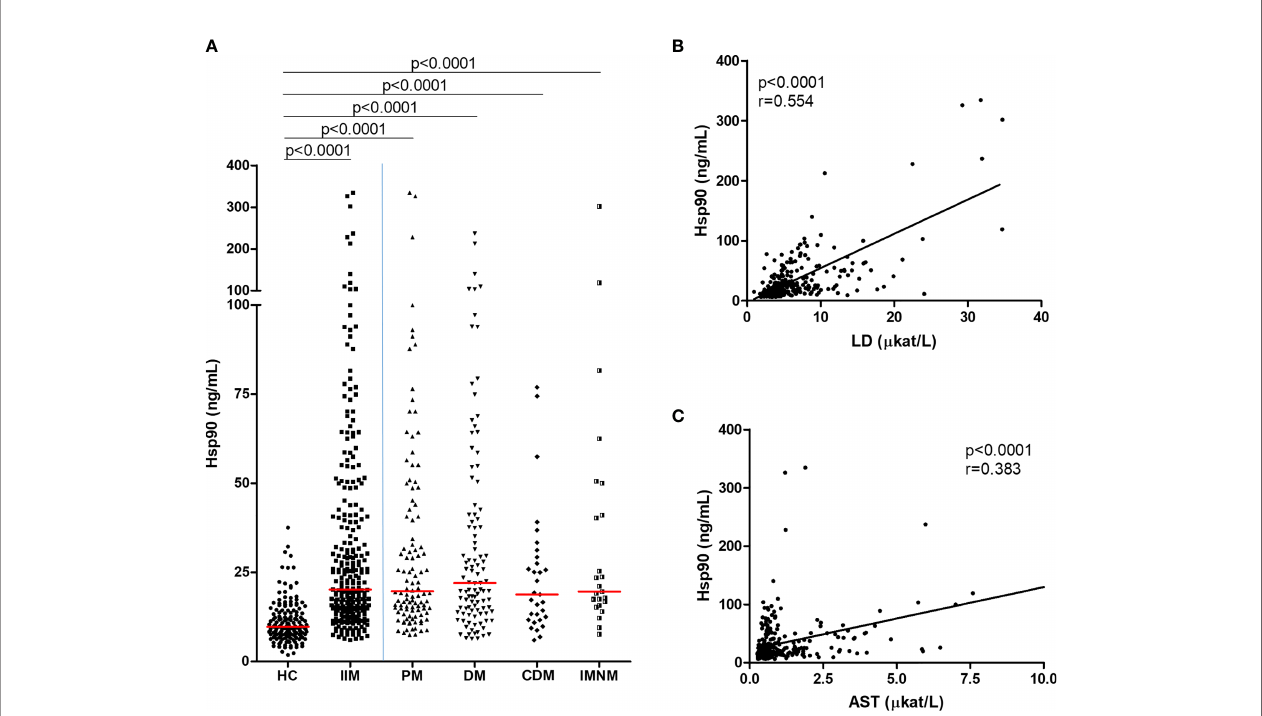
FIGURE 1 | Plasma Hsp90 levels were increased in patients with IIM compared to healthy controls and were associated with serum markers of muscle damage. (A) Systemic levels of Hsp90 are signi fi cantly elevated in patients with idiopathic in fl ammatory myopathies (IIM) and individual subtypes of IIM (PM, polymyositis; DM, dermatomyositis; CDM, cancer-associated dermatomyositis and IMNM, immune-mediated necrotizing myopathy) compared to healthy controls (HC). Horizontal bars represent the median. Increased plasma Hsp90 is associated with elevated serum levels of (B) lactate dehydrogenase (LD) and (C) aspartate aminotransferase (AST).